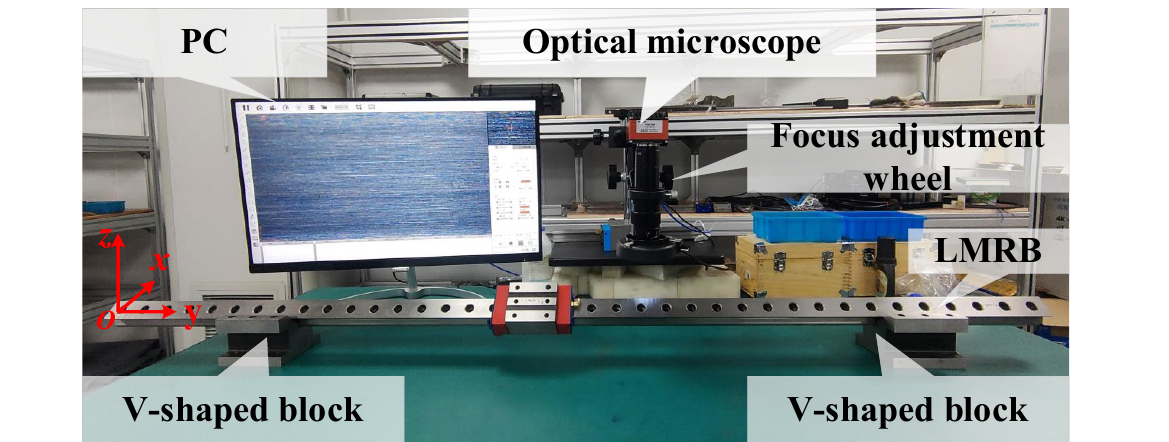
Figure 5. Micrograph measuring device.